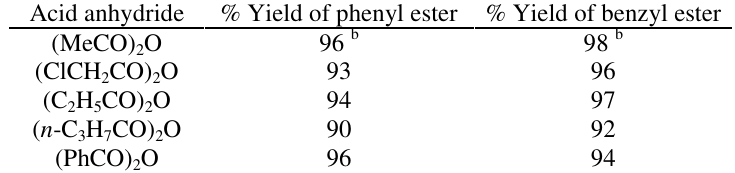
Table 4. WD-Acylation of phenol and benzyl alcohol with acid anhydrides a Acid anhydride % Yield of phenyl